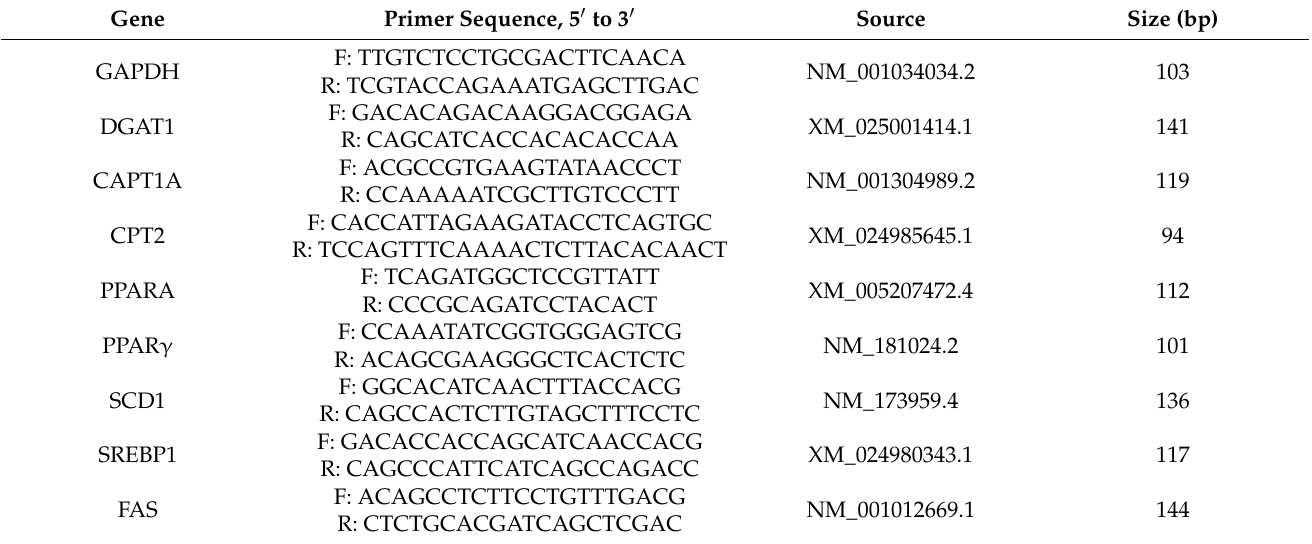
Table 1. Primer sequences used in this